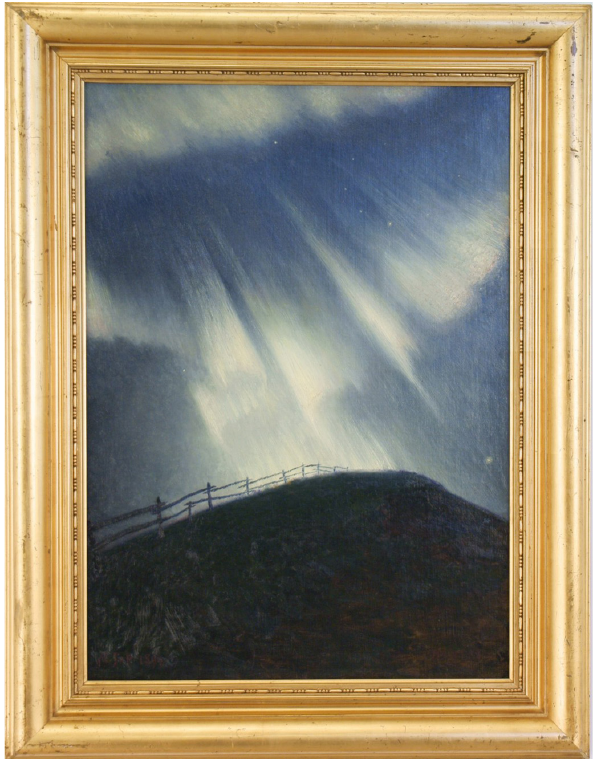
Figure 19. Aurora over Akureyri on 1 September 1899 at 17:45h. The first successful painting by Harald Moltke (Photo,